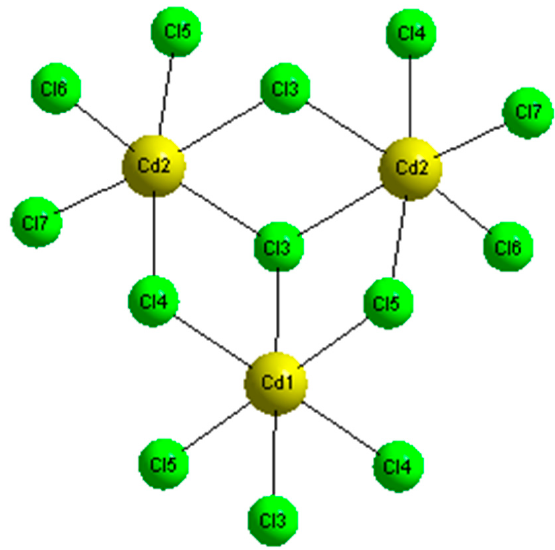
Figure 5. The [Cd 3 Cl 10 ] 4 − trimer coordination. Figure 5. The[Cd 3 Cl 10 ] 4 − trimer coordination.